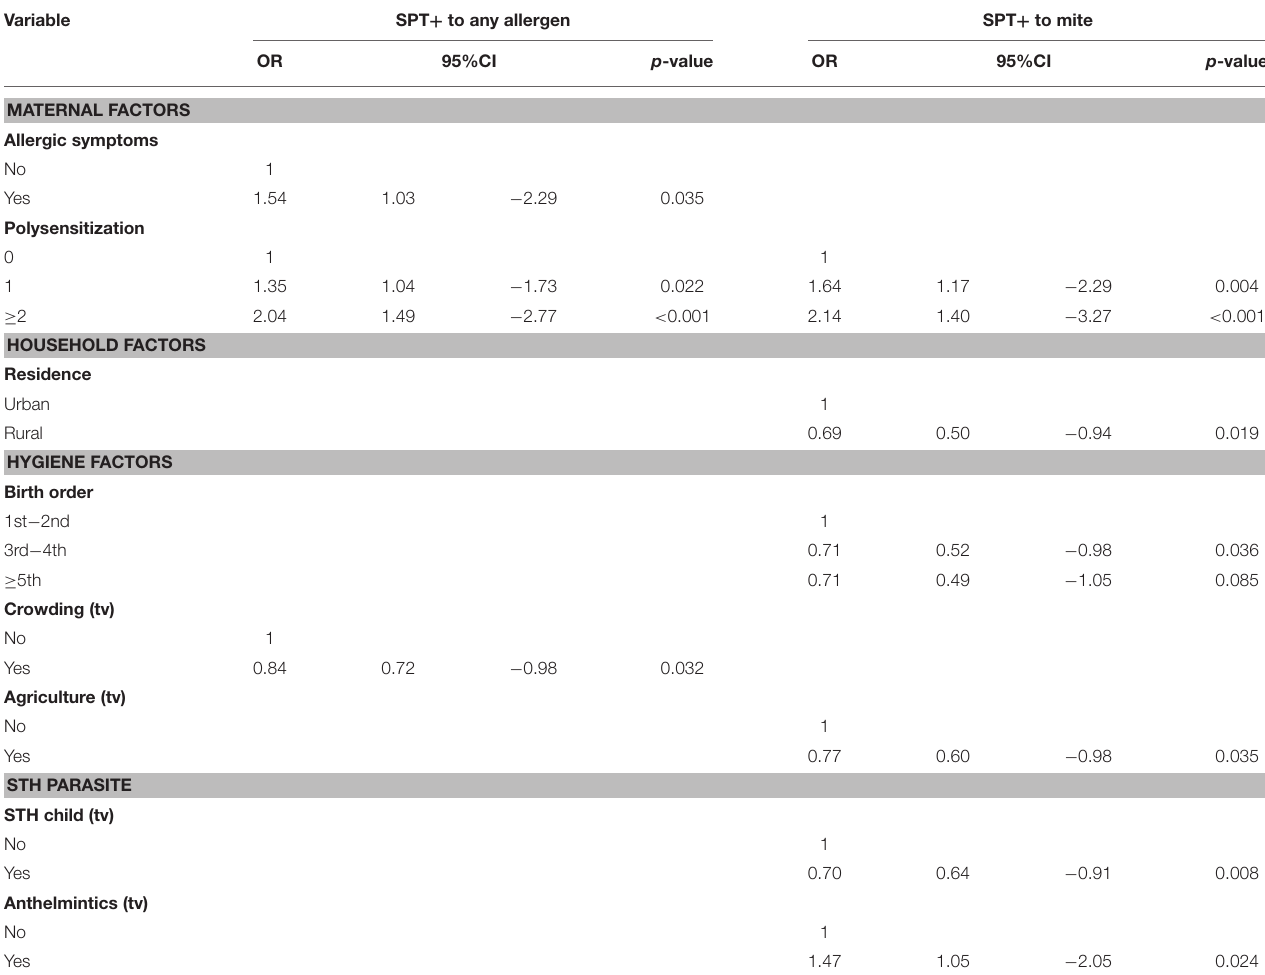
TABLE 2 | Multivariable associations between risk of allergen skin prick test positivity (SPT + ) to any and to mite allergens during first 8 years of life and child, parental, household, and hygiene factors. Variable SPT + to any allergen SPT + to mite OR 95%CI p -value OR 95%CI p